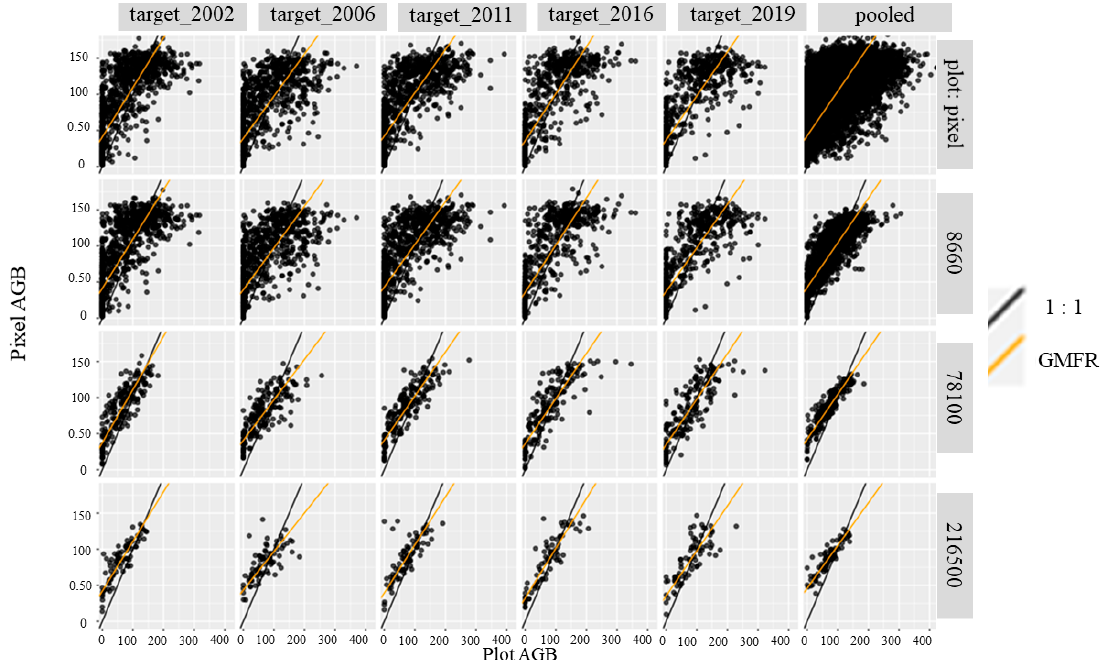
Figure 11. The 1:1 and GMFR lines across scales—FIA plots vs. mapped (SI corrected). Results of Assessment 3: Figure 12 demonstrates the mapped differences in the mod- eled area estimates at the 216,500 ha scale with respect to plot-based confidence intervals for 2002, 2006, 2011, 2016, 2019, and the pooled datasets. In the 2002 map, about 60% of the time, the mean biomass estimates fall within the 95% confidence interval. About 66% of the time, the mean biomass estimates fall within the 95% confidence interval for 2006. As the 2011 distribution map indicates, approximately 72% of the time, the mean biomass estimates fall within the 95% confidence interval. About 77% of the time, the mean bio- mass estimates fall within the 95% confidence interval for 2016. The 2019 mean biomass values fall within the 95% CI associated with the plot means of 86% of the time. For the pooled dataset, 28% of the time, the mean biomass estimates fall within the 95% confi- dence interval. In Figure 12, the largest errors occur outside the airborne LiDAR AGB pilot areas. It should be noted that training/testing datasets are within the four pilot areas; how- ever, the proposed model predicts the AGB for the entire NYS.